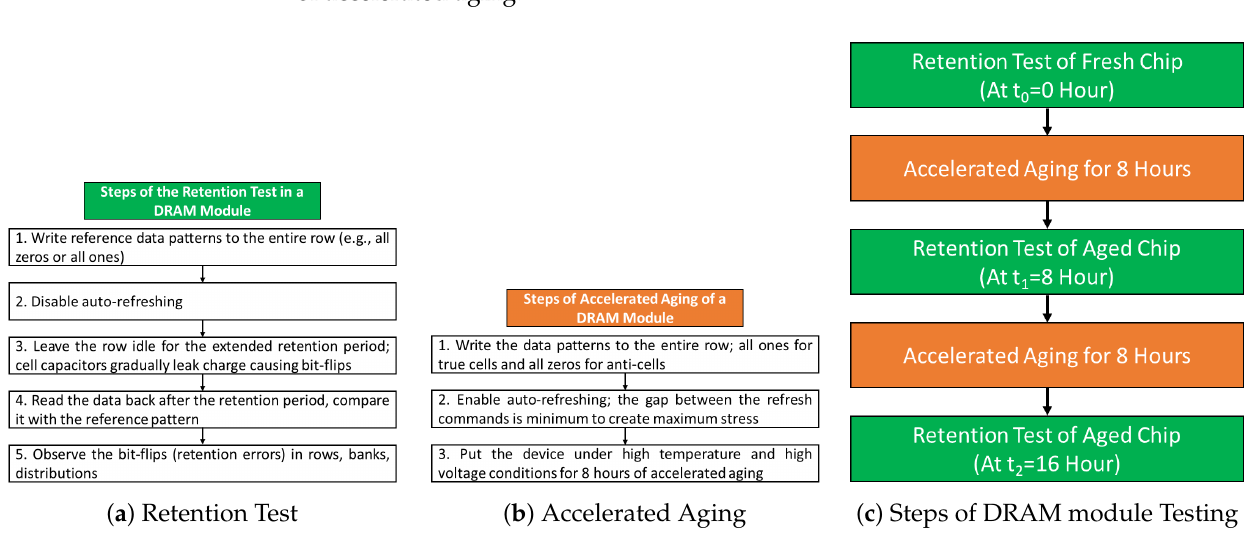
Figure 3. Overview of the testing methodology of a DRAM